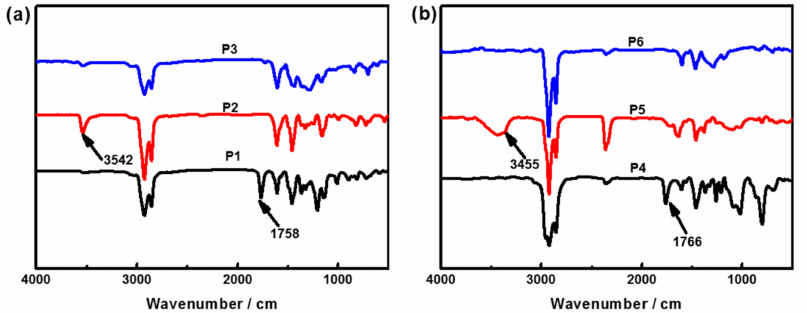
Figure 6. FTIR spectra of polymers before and after intramolecular cyclization